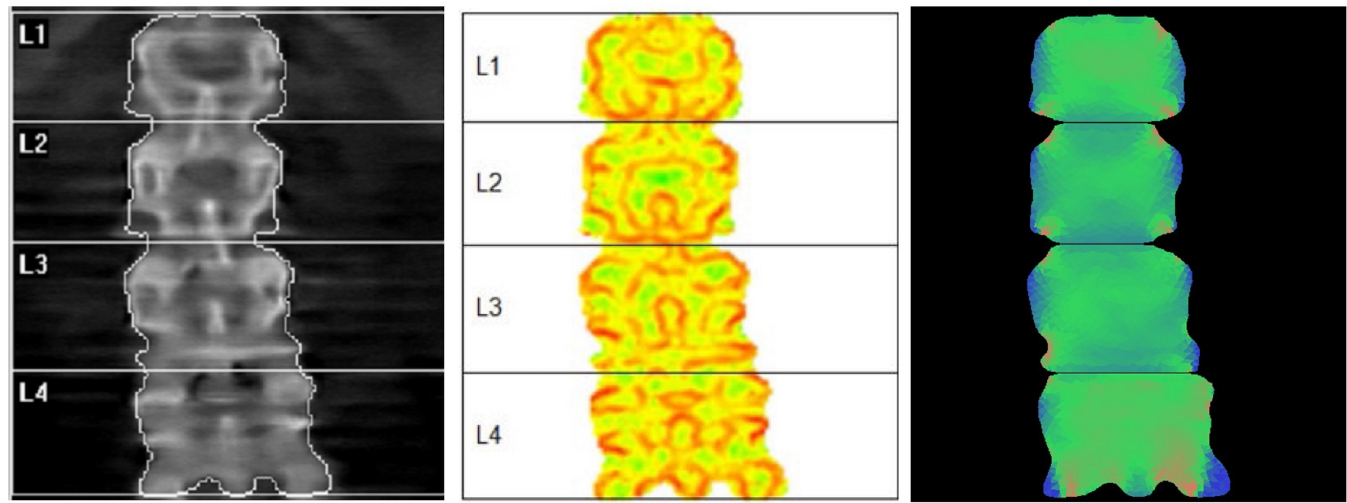
Fig 1. Example of a DXA image showing the three parameters that we used: BMD, TBS and BSI analysis.